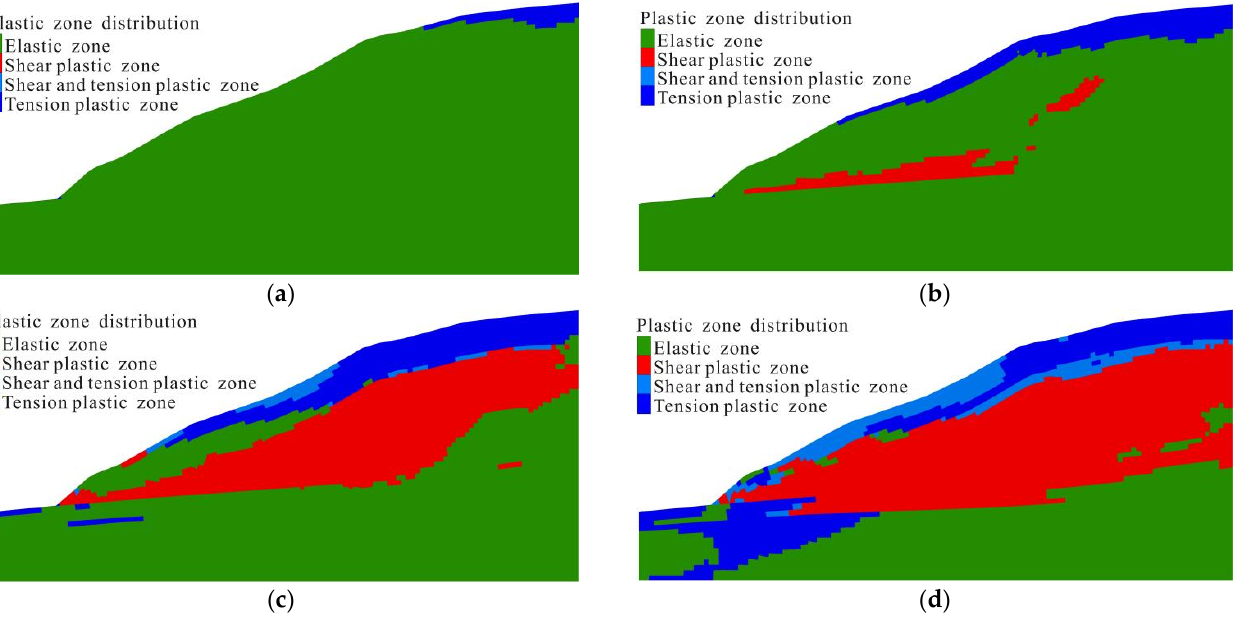
Figure 16. Plastic zone in the model slope without fault zone at input PGA of ( a ) a = 0.1 g, ( b ) a = 0.2 g, ( c ) a = 0.3 g, and ( d ) a = 0.4 g.